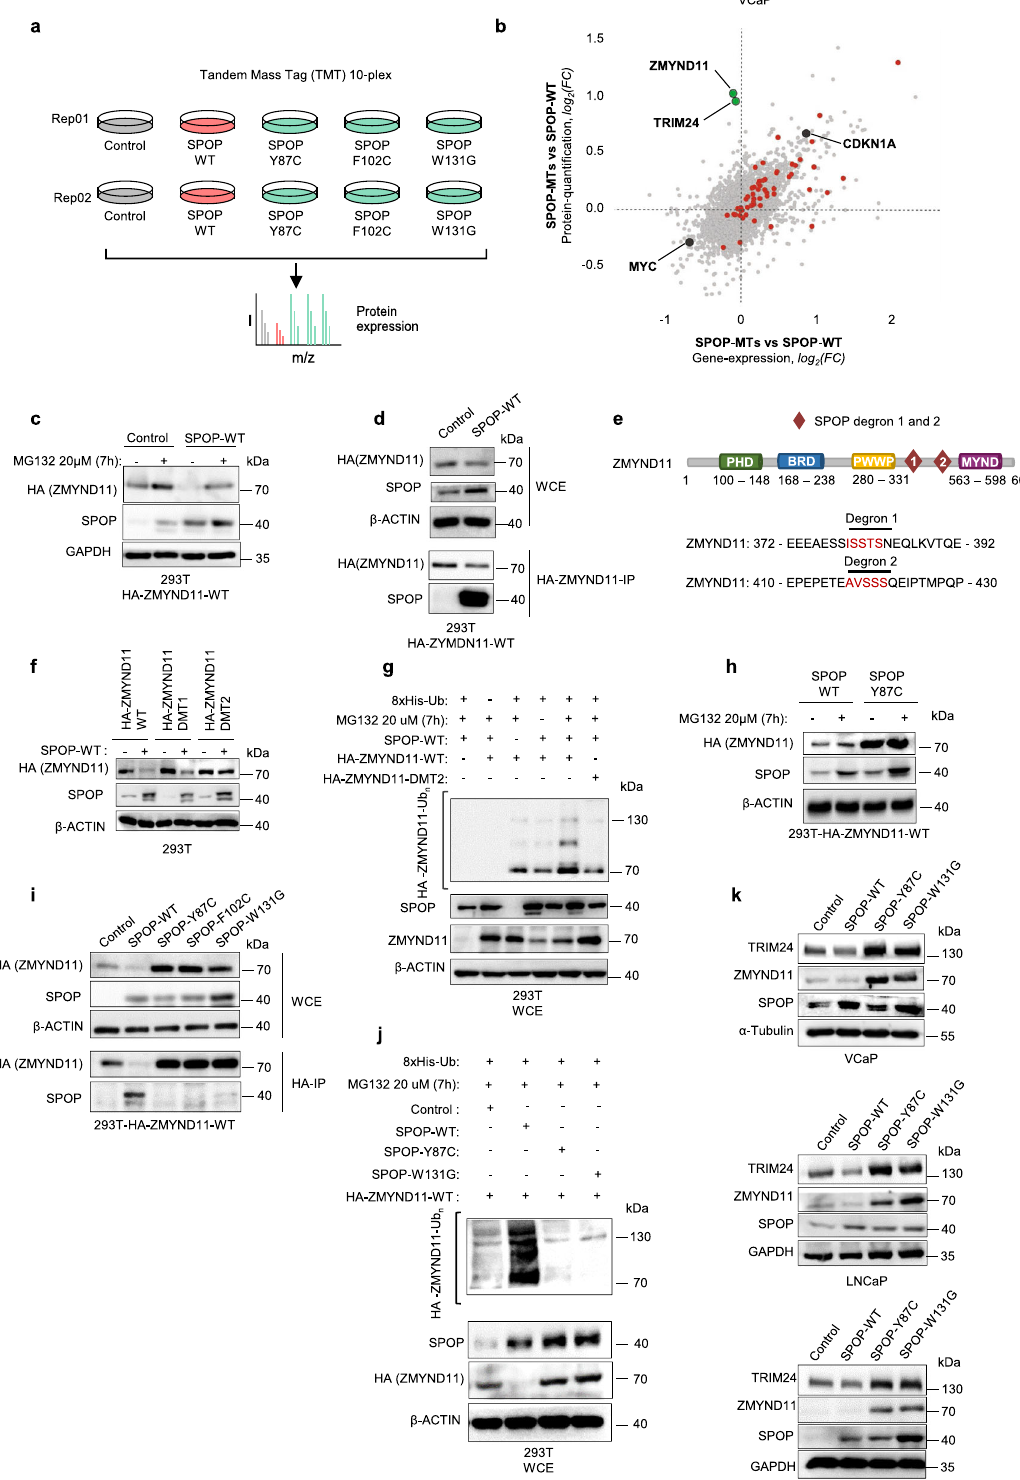
impaired ERG-mediated gene transcription (Supplementary Fig. 10e, f and Supplementary Data 23 and 24). In accordance with the ability of mutant SPOP to repress the function of endogenous wild type SPOP in a dominant-negative manner, the over-expression of mutant SPOP (SPOP-Y87C, -F102C, -W131G, -F133S) phenocopied the effect of SPOP knockdown on ERG- mediated invasion in PC3 cells (Supplementary Fig. 10g, h).